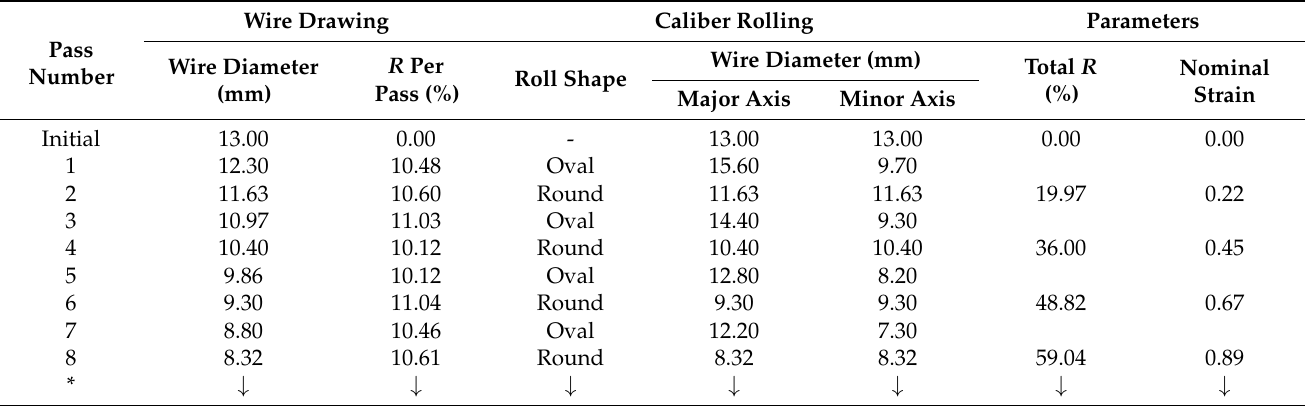
Table 2. Process setting of dies for wire drawing and rolls for caliber